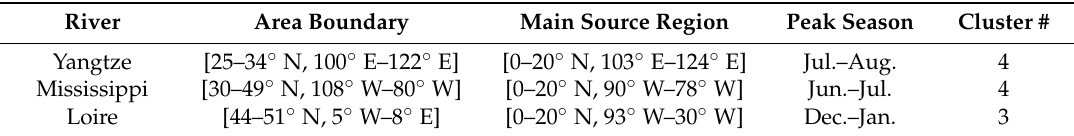
Figure 3. Tropical moisture source identification for the Loire river basin. Plot ( A ) shows the study area in the red box, which is used to filter the TMEs tracks. Only those tracks entering the red box are retained to produce Plot ( B ). Plot ( B ) shows the calendar day average moisture tracks originating in the tropics [0–20° N] and entering the red box in Plot ( A ). The color scale reference bar for Plot ( B ) is on the bottom right. The band between the yellow lines in Plot ( B ) is defined by finding the yellow lines that the average annual total number of tracks starts to exceed the 80th percentile. Plot ( C ) shows the calendar day maximum and minimum numbers of tracks over the entire data period, originating within the region banded by the yellow lines in Plot ( B ). Plot ( D ) shows the four global TMEs source hotspots (‘PE,’ ‘GP,’ ‘GS’ and ‘WP’). The identified major TMEs source for the Loire is highlighted by the yellow box in Plot ( D ), corresponding to the banded area in Plot ( B ). Units of Plot ( B ) and Plot ( C ): number of tracks. Table 1. Summary of the case study locations, their main TMEs moisture source regions, the peak seasons and the resulting numbers of clusters from the analysis.